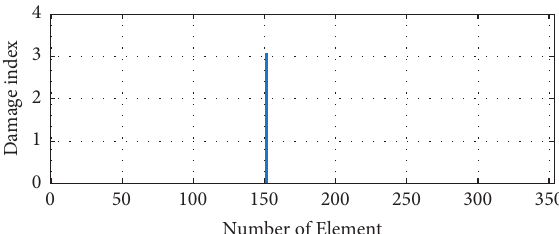
Figure 26: Results of single damage case D2 using MCA-DI (setback building).